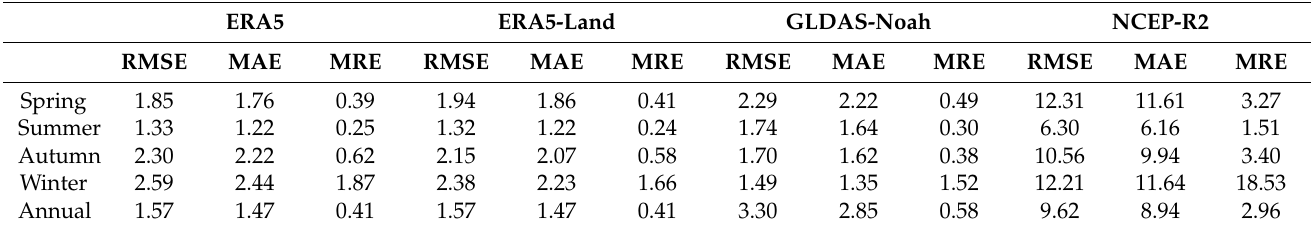
Table 2. Error statistics of the ∆ T values estimated using the 4 reanalysis data products against those calculated from the observation data of 84 stations across the QTP from 1981 to